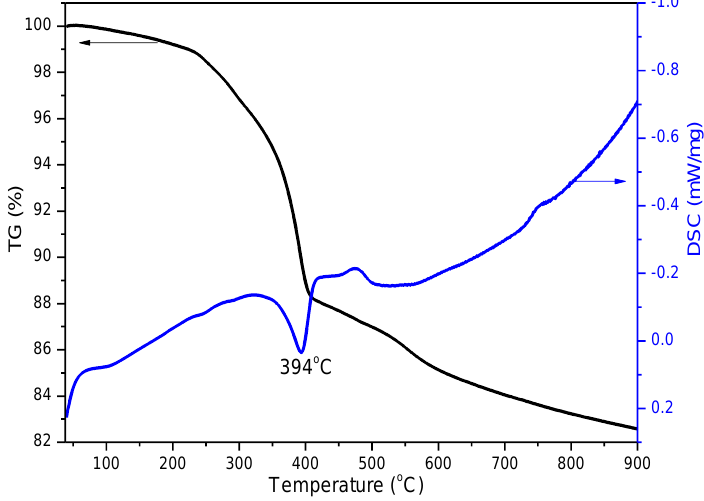
Figure 6. Hermogravimetry and Differential Scanning Calorimetry TG-DSC curve of the GaOOH precursor.